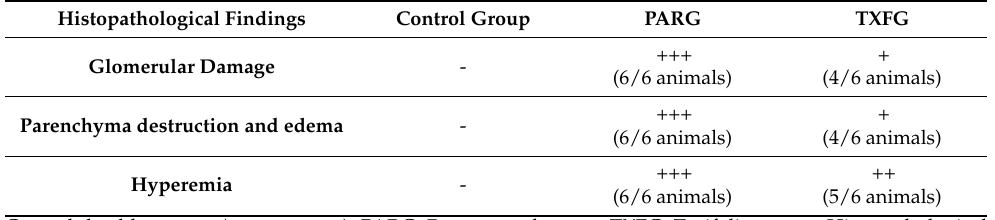
Table 2. Summary of the histopathological scores based on H and E staining results for kidney tissues. Histopathological